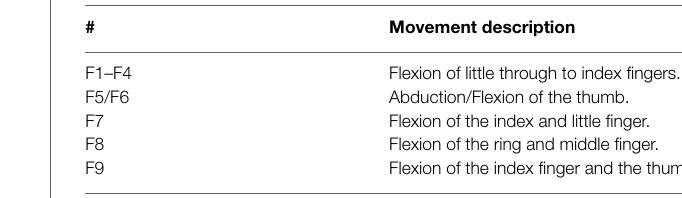
TABLE 2 | Description of the 9 force